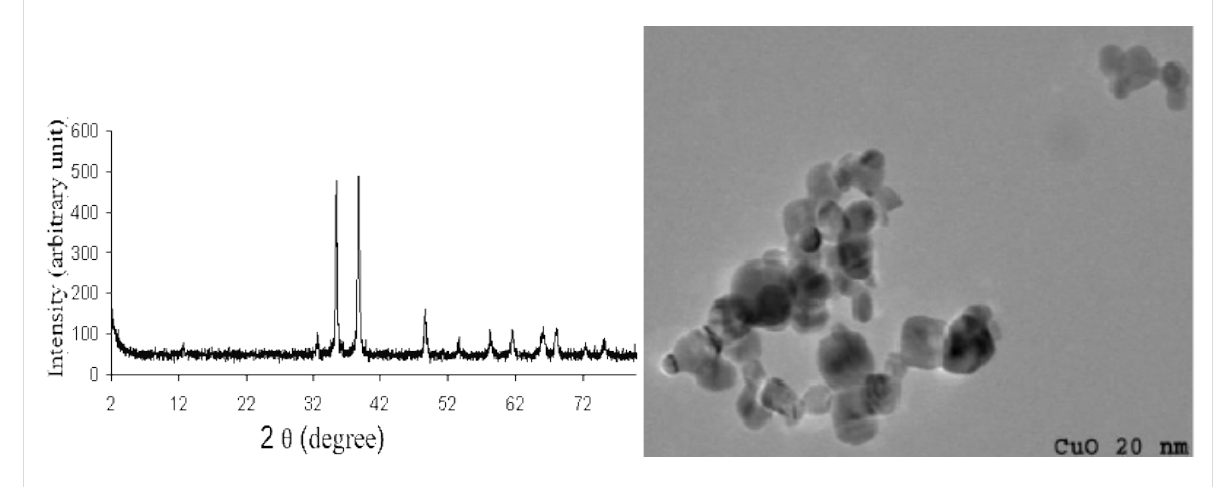
Figure 3: Powder X-ray diffraction pattern and TEM image of recycled CuO-nanoparticles.